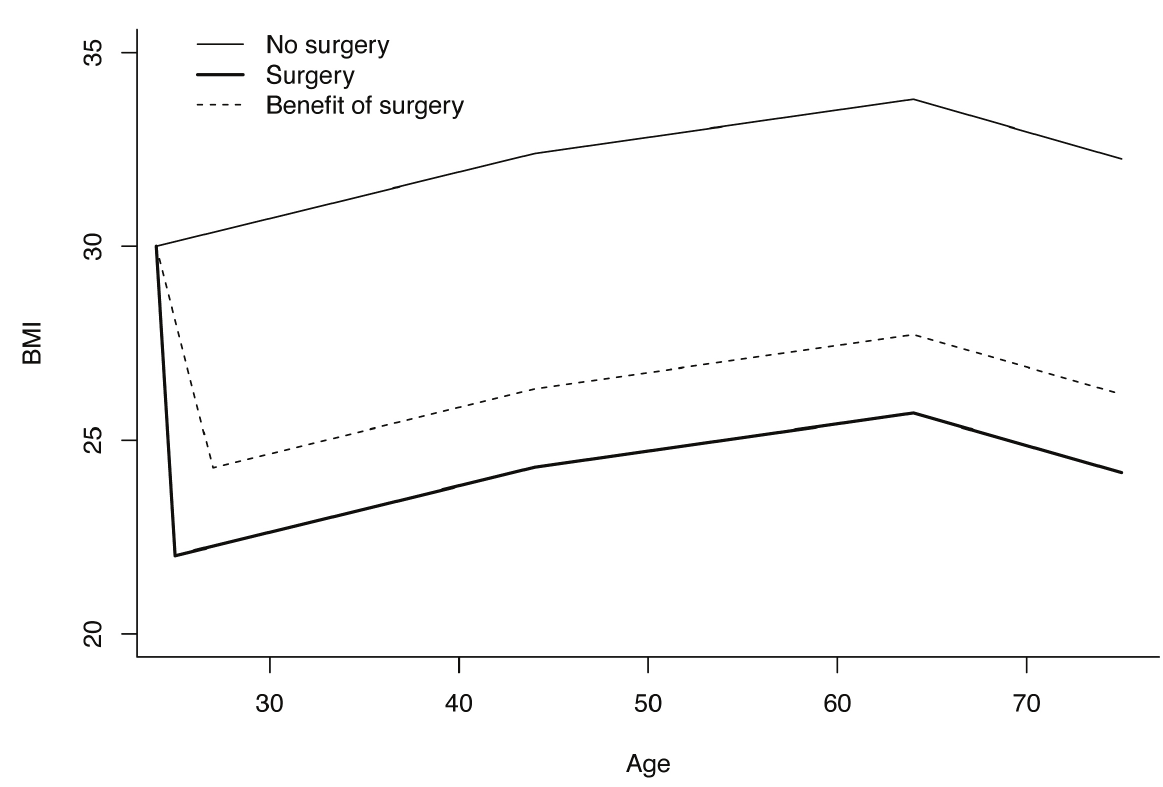
Figure 3: Body Mass Index (BMI) over time Change in BMI over time, depending on initial surgery or not, and the accrued benefit of surgery in the